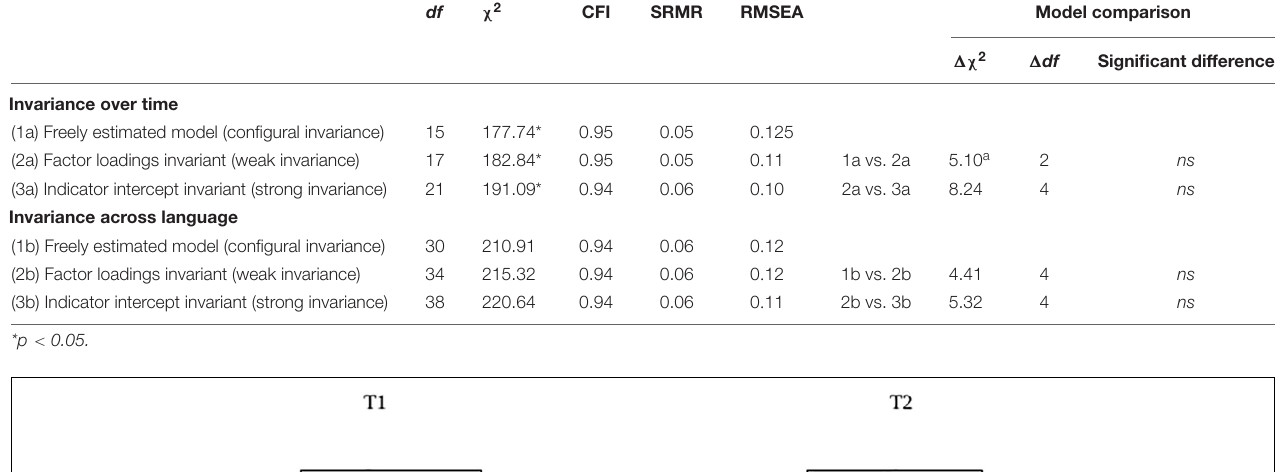
TABLE 2 | Results of the invariance tests across T1 and T2 and across language ( N = 699). df χ 2 CFI SRMR RMSEA Model comparison